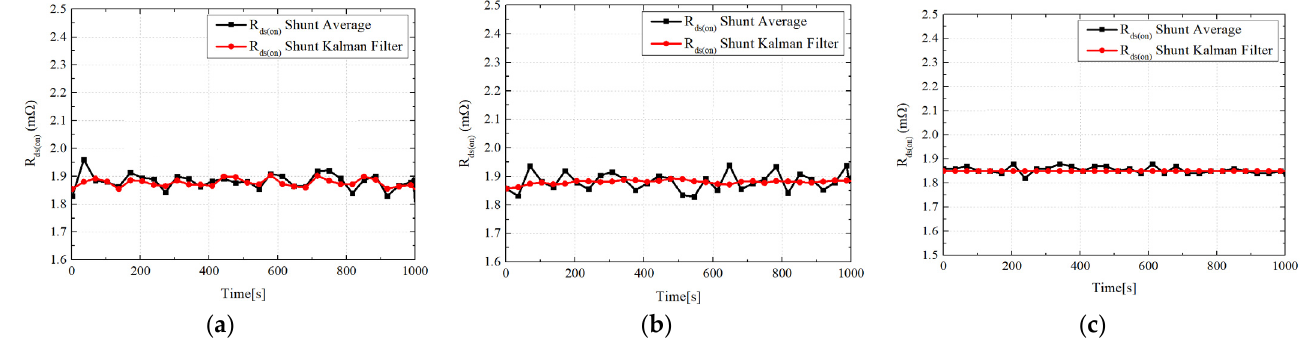
Figure 10. Average value vs. Kalman filter value ( a ) Q = 0.7, R = 1;( b ) Q = 0.1, R = 1;( c ) Q = 0.1, R = 2.